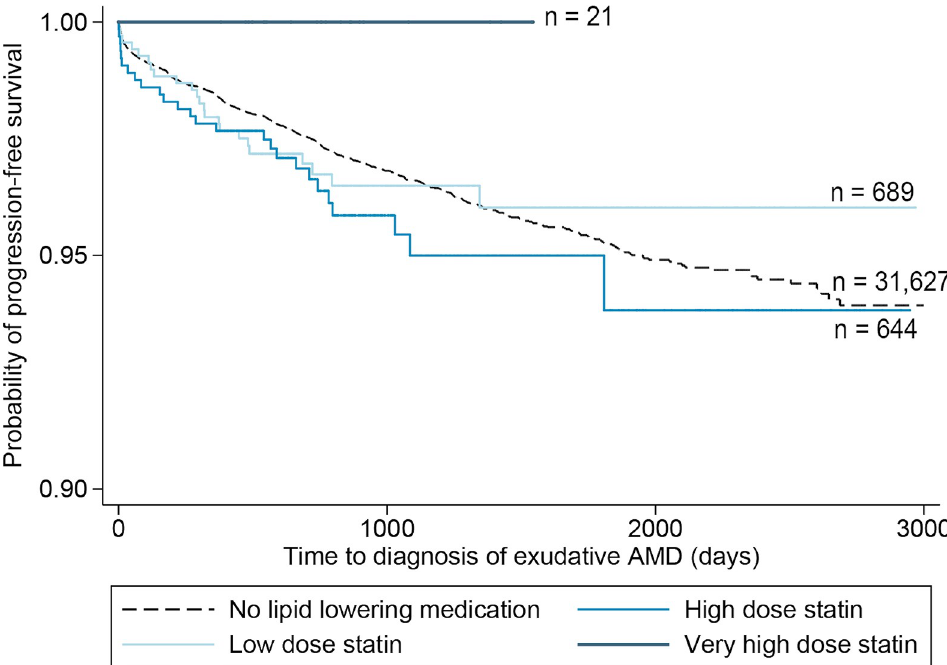
Fig 2. Time to progression from non-exudative to exudative age-related macular degeneration (AMD) by dose of lipophilic statin. No patients taking very-high-dose lipophilic statins (atorvastatin 80 mg) converted from non- exudative to exudative AMD.